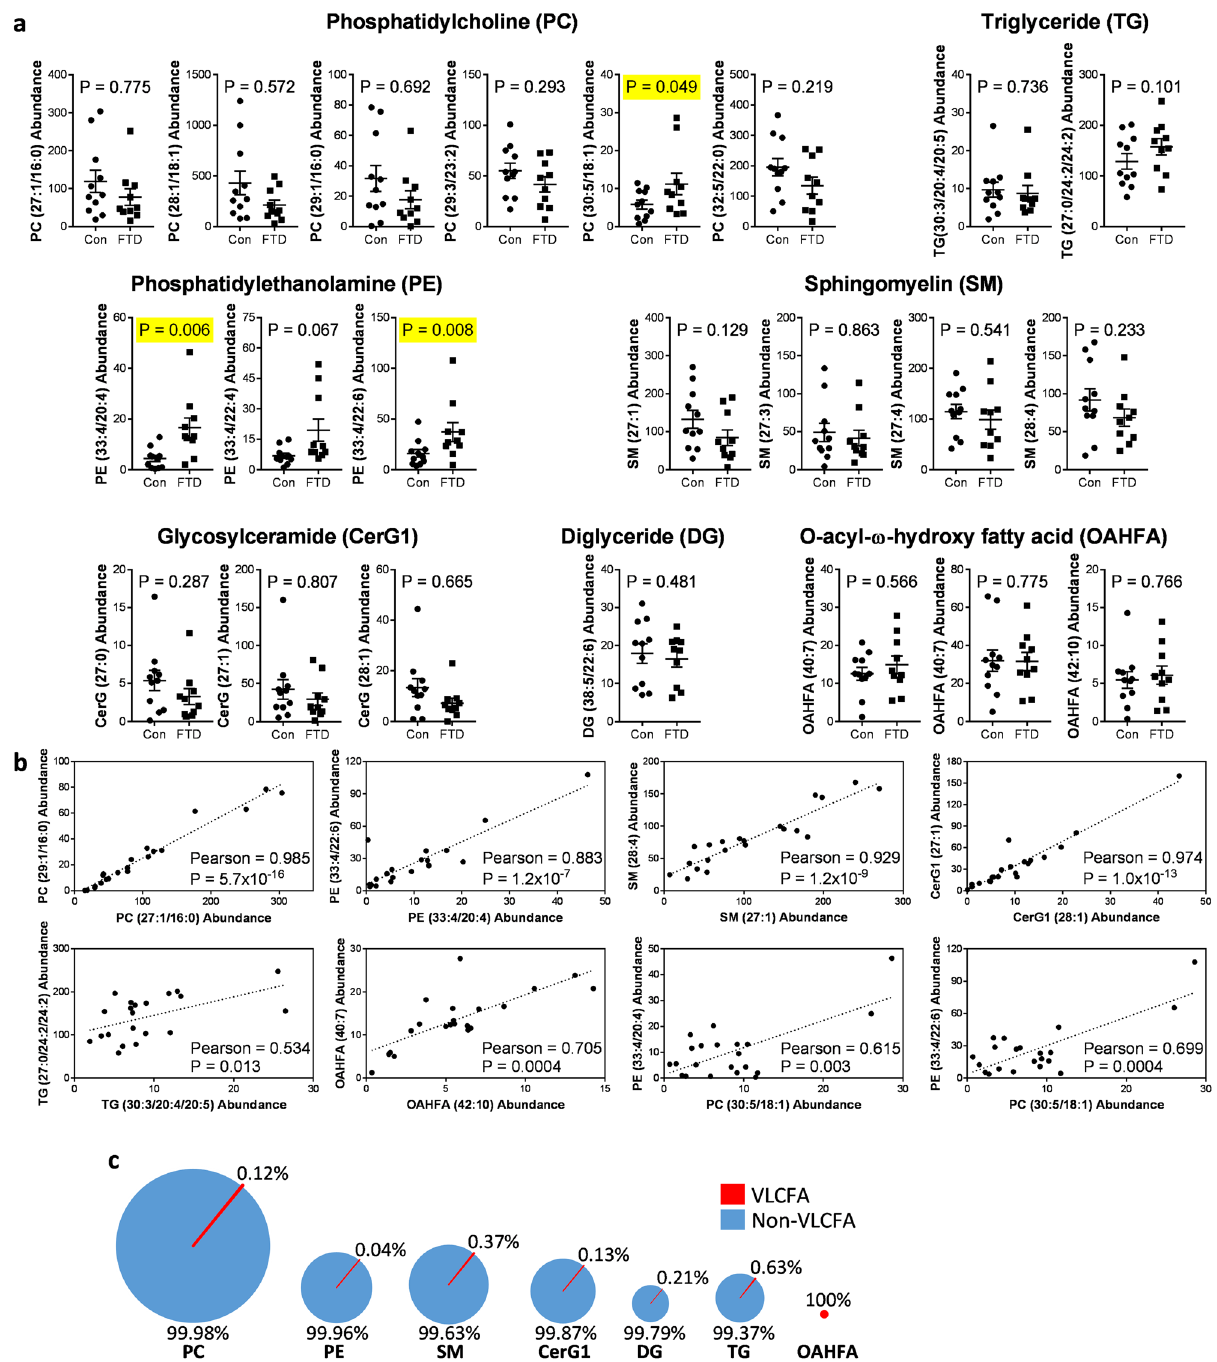
Figure 1. VLCFA-lipids are increased in FTD brain. ( a ) We identified 22 VLCFA-lipid species in the human brain as measured by quantitative discovery lipidomics LC/MS. Multivariate analysis (general linear model), co-varying for age and sex, was used to determine lipids significantly altered in FTD (n = 10) compared to controls (n = 11) and are highlighted in yellow. Relative abundance of lipids was obtained from LC/MS peak areas normalized to internal standards. Data represent mean and SE as error bars. ( b ) Pearson correlation (combined of both FTD cases and controls) was used to determine the relationship between VLCFA-lipid species. ( c ) Distribution of VLCFA-lipids compared to non-VLCFA-lipids for each lipid